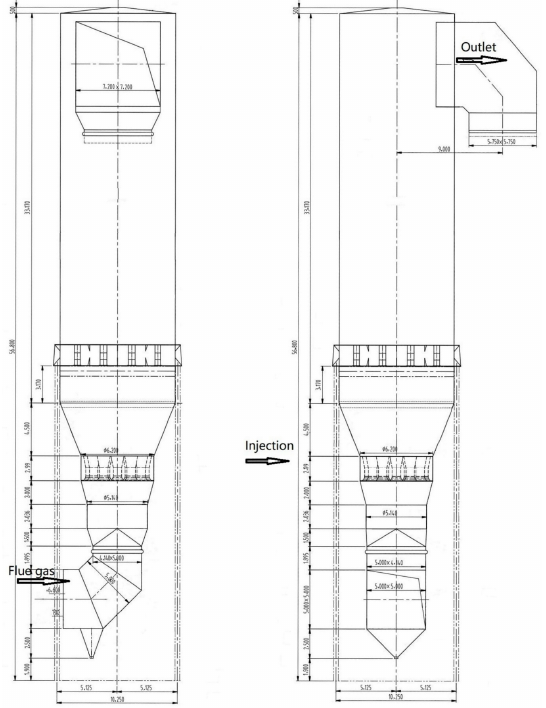
Figure 2. Schematics of the desulfurization tower. Table 1. The geometry parameters of the desulfurization tower.